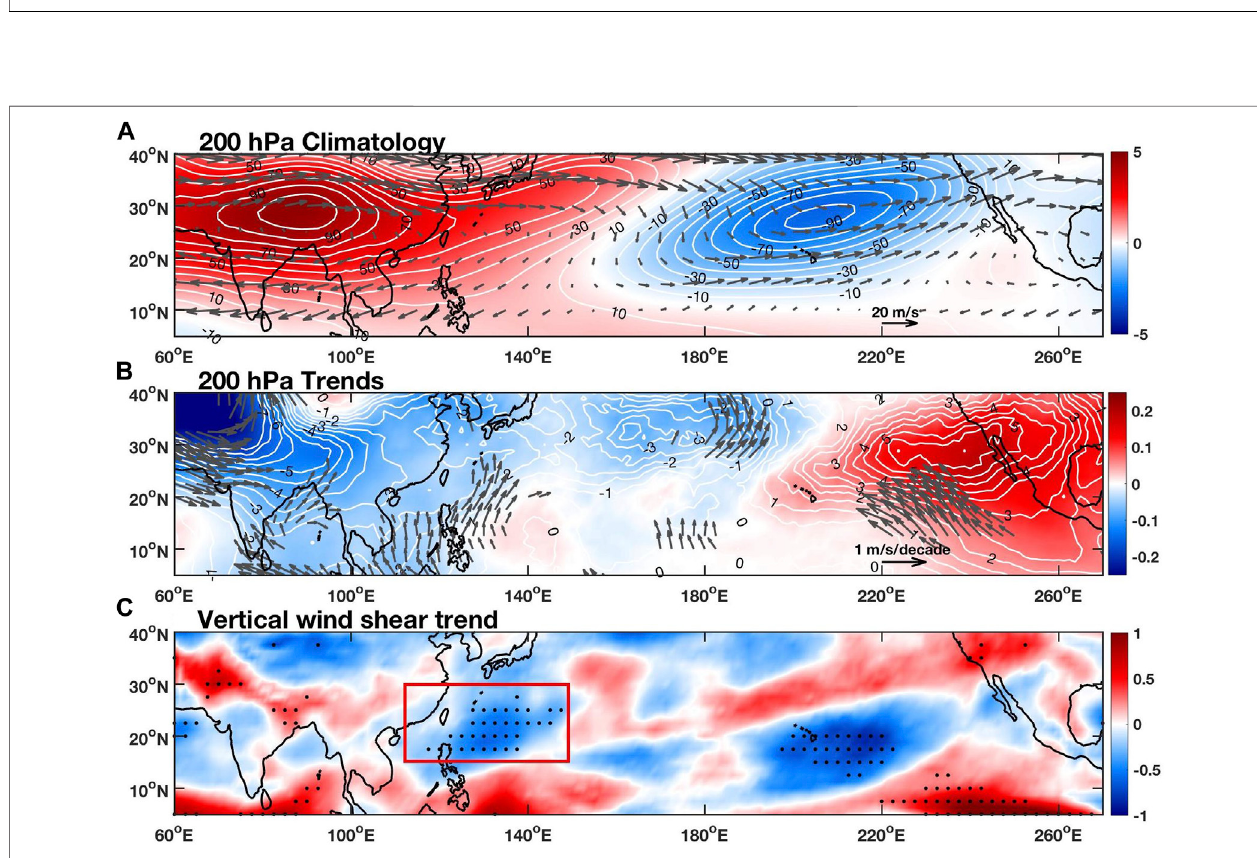
FIGURE12| GeneralcirculationchangeandweakenedverticalwindshearoverfarwesternWNP. (A) 1970 – 2016summerseason(JJASO)climatologicalvaluesof the500 – 200 hPalayermeaneddytemperature(i.e.withzonalaverageremoved;shading,Units:K),200 hPaeddygeopotentialheight(contours,Units:m),and200 hPa wind (vectors Units: m/s). (B) Same as (A) but for linear trends (in per decade) of the same variables. (C) Linear trend of vertical wind shear (m/s per decade) in JJASO, 1970 – 2016.TheregionintheredboxiswheremostofWNPlandfallingtyphoonspassby.Vectorsin (B) andblackdotsin (C) denotetrendsignalspassingthe0.05 signi fi cance level according to the Mark – Kendall